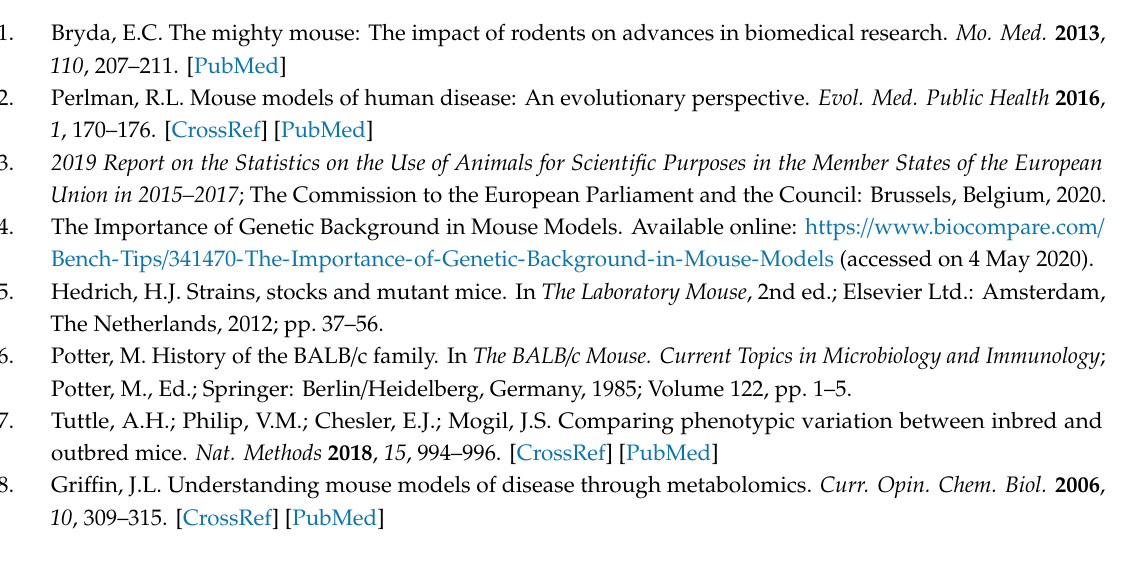
Figure S1: Ion map (molecular weight versus retention time) of all extracted metabolites following LC-MS analysis in positive ionization mode, Figure S2: Principal component analysis (PCA) plot of all analyzed samples and extraction quality control (QC) samples, Figure S3: 3D PCA score plots of untargeted metabolomics data of tissues collected from three di ff erent mouse strains. Examined strains included: BALB / c (red), C57BL / 6 (green), and CD1 (blue). Tissues analyzed included: brain (a), liver (b), kidney (c), and muscle (d), Figure S4: Loadings plots of PLS-DA. Tissues analyzed were: brain (a), liver (b), kidney (c), muscle (d), Table S1: Details of detected features, Table S2: Validation metrics of PLS-DA models, Table S3: Metabolic pathways and involved metabolites di ff erentiating tissues of C57BL / 6, BALB / c and CD1 mice strains, Table S4: Isotope pattern matching analysis of di ff erential metabolites using the ChemSpider